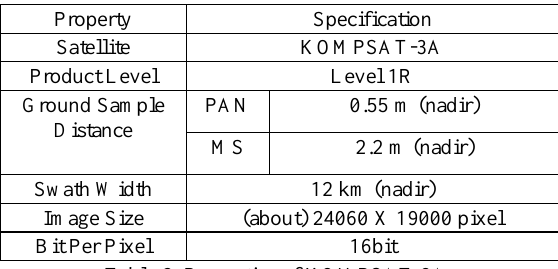
Table 2. Properties of KOMPSAT-3A.